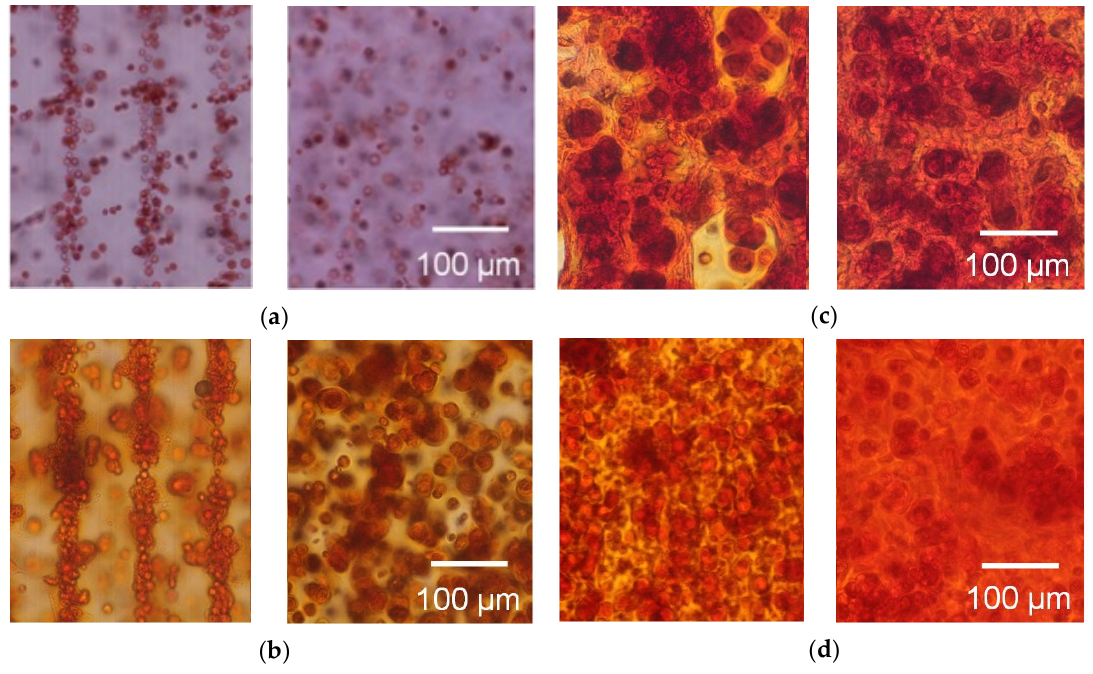
Figure 9. Safranin-O staining of the agarose gel-sheet constructs cultured for ( a ) 0, ( b ) 7, ( c ) 14, and ( d ) 21 days. Left: cell-patterned specimens; right: homogeneously cell-dispersed specimens.